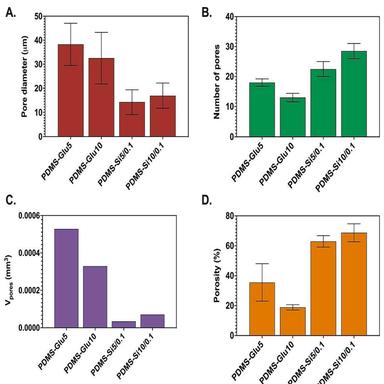
A. Pore dimensions of MNs. Error bars represent SD (n = 20). B. Number of pores. Error bars represent SD (n = 3), C. Total volume of pores D. Porosity percentage of modified PDMS MNs samples. Error bars represent SD (n = 3).